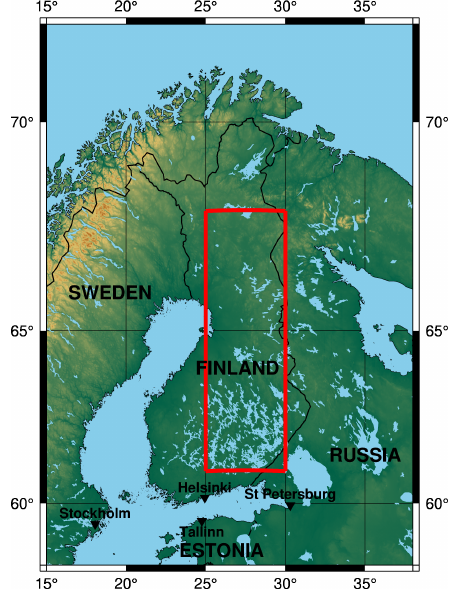
Figure 1. The area used in the spatially averaged forecasts in Fin-